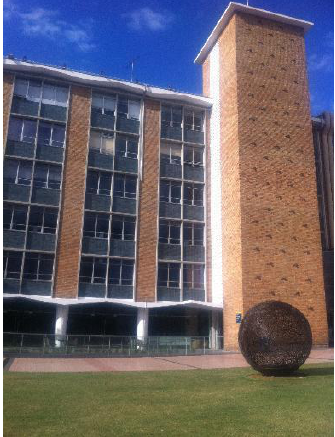
Figure 5. Query image No. 3 with GPS tag information: Zone 56, Latitude: −33°55'5.40120'', Longitude: 151°13'52.79880'', Altitude: 33.92 m; digital compass measurement: 34°NE.